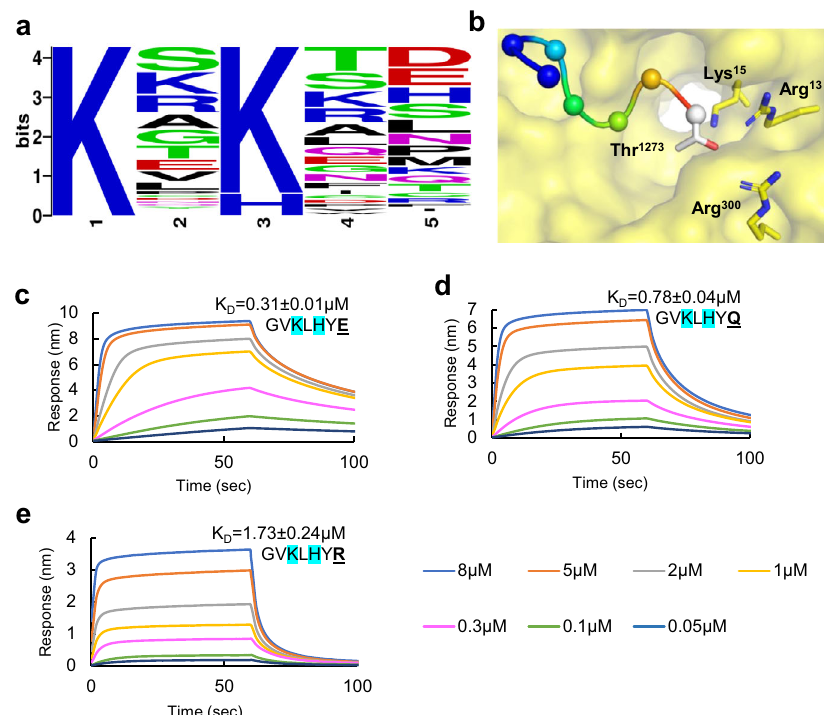
Fig. 4 In silico and biophysical analysis of spike C-terminal position in α COPI-WD40 binding. a Sequence logo generated from the alignment of K-x- H(K)-x-x sequence in 119 proteins predicted to be in the human membrane proteome. This shows the abundance of Lys in the fi rst and third positions, low frequency of aromatic residues in the penultimate position, and the abundance of Asp and Glu in the C-terminal position. b An in silico model of the spike hepta-peptide on α COPI-WD40 (yellow surface) shows an abundance of basic residues in the vicinity of the terminal Thr 1273 spike residue. Panels ( c – e ) show results of a BLI analysis of binding between spike hepta-peptide mutants and α COPI-WD40. The equilibrium K D is provided with each sensorgram for comparison. Color code for concentrations is given at the bottom of the fi gure. Stabilization of the spike hepta-peptide complexed with α COPI-WD40 is observed when the terminal position contains either, ( c ) acidic Glu 1273 , or ( d ) neutral Gln 1273 residue. e In contrast, basic Arg 1273 in the spike hepta-peptide does not favor enhanced binding. These data show a role of this terminal hepta-peptide position in modulating tight binding to α COPI-WD40. In ( c – e ), one representative experiment of three is